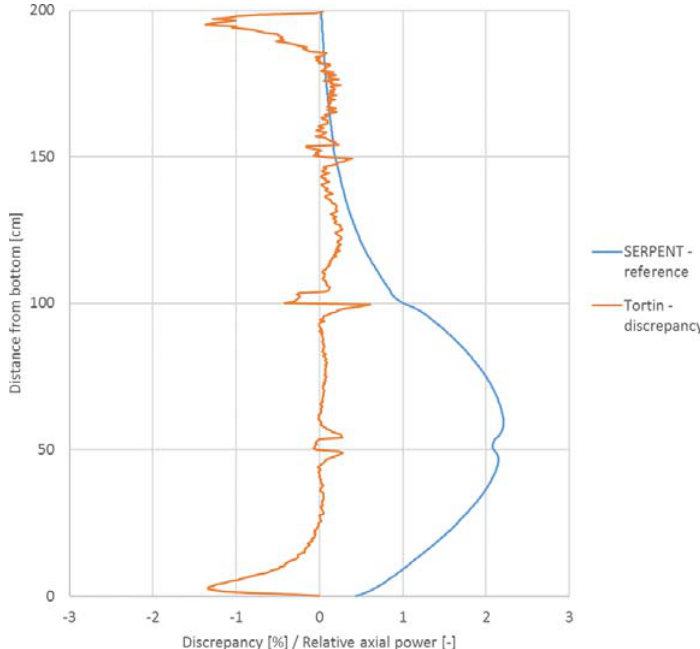
Figure 6. Axial power profile calculated by SERPENT and power error of Tortin using SERPENT cross sections.